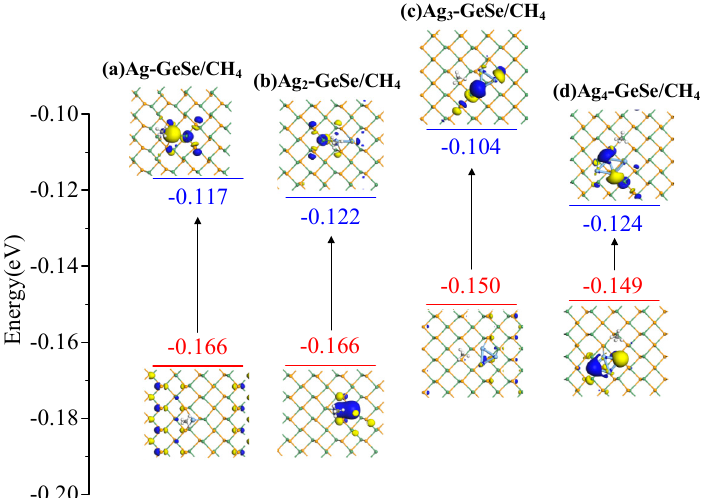
Figure 9. HOMO and LUMO distribution after CH 4 adsorption. ( a ) Ag-GeSe/CH 4 system ( b ) Ag 2 - GeSe/CH 4 system ( c ) Ag 3 -GeSe/CH 4 system ( d ) Ag 4 -GeSe/CH 4 system. Table 3. Energy of HOMO, LUMO, and energy gap of CO and CH 4 adsorbed Ag n -GeSe systems.